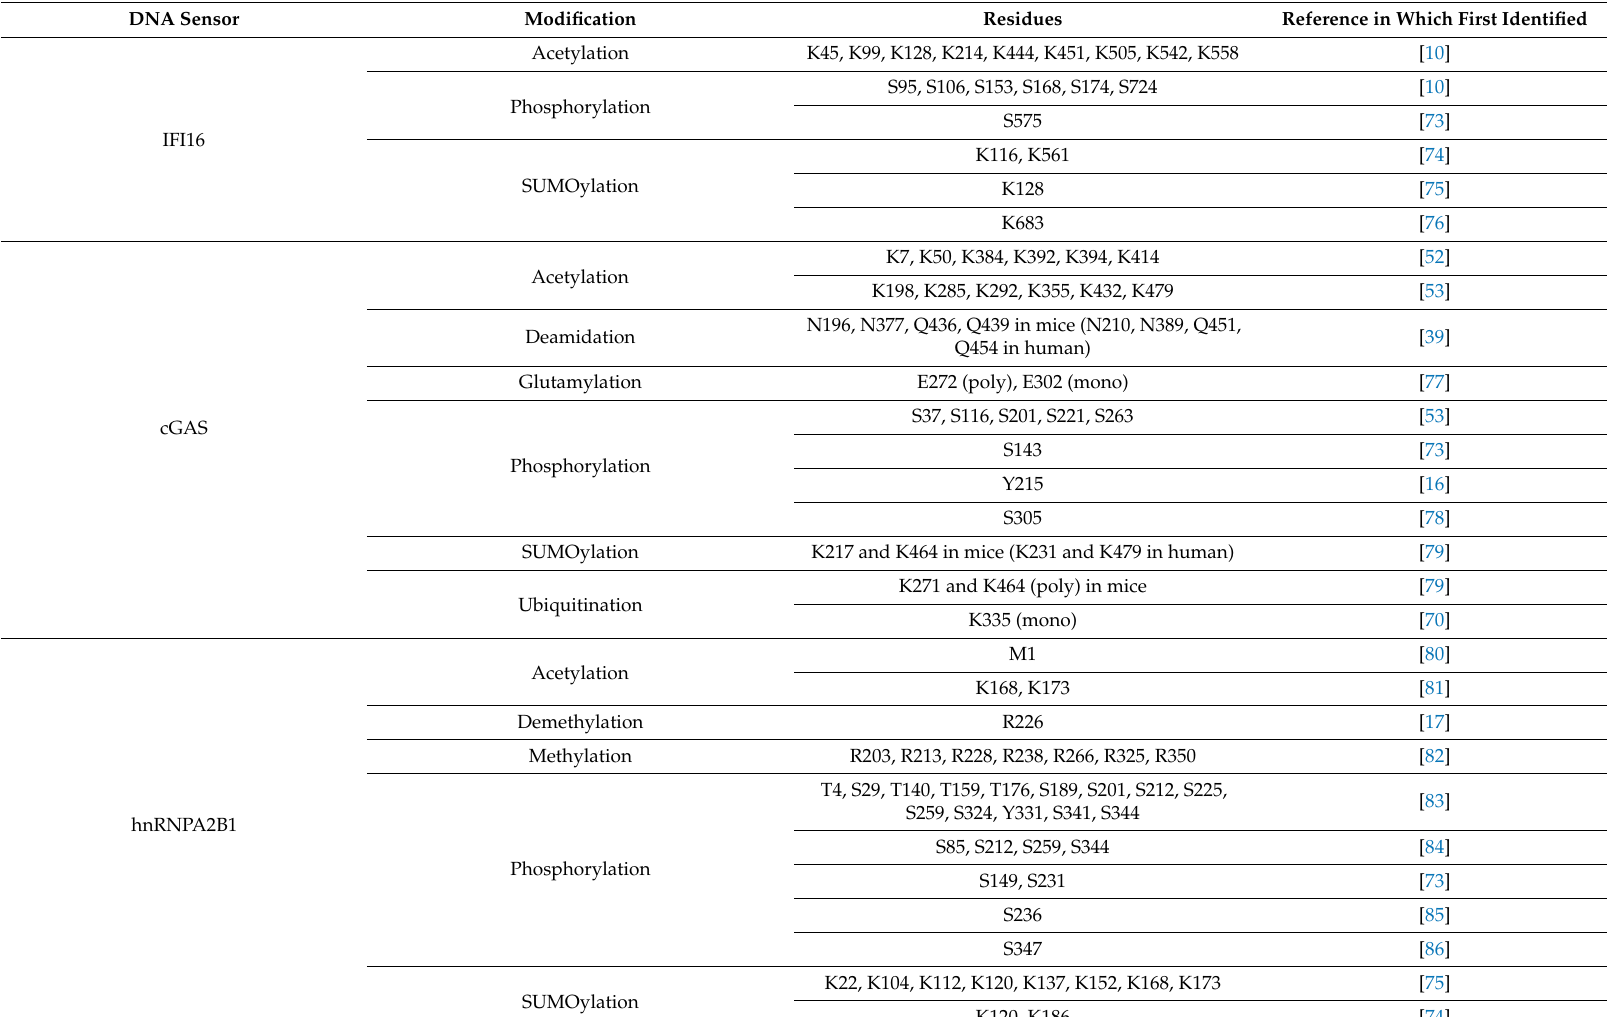
Table 2. Known post-translational modifications of nuclear DNA